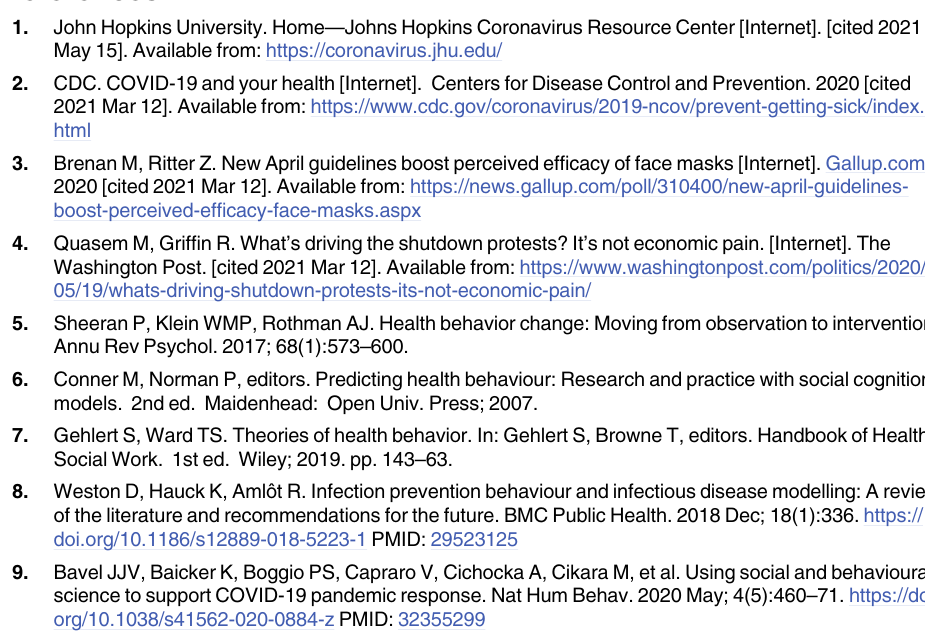
S8 Table. Multiple regression models predicting reasons for general health behaviors in Study 3. S9 Table. Additional robustness checks predicting COVID-19 health behaviors and rea- sons for those behaviors in Study